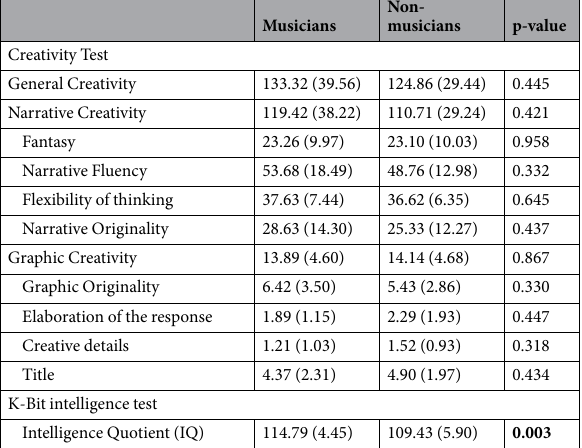
Table 1. Behavioral data on creativity and IQ tests (means and standard deviations [SD]).